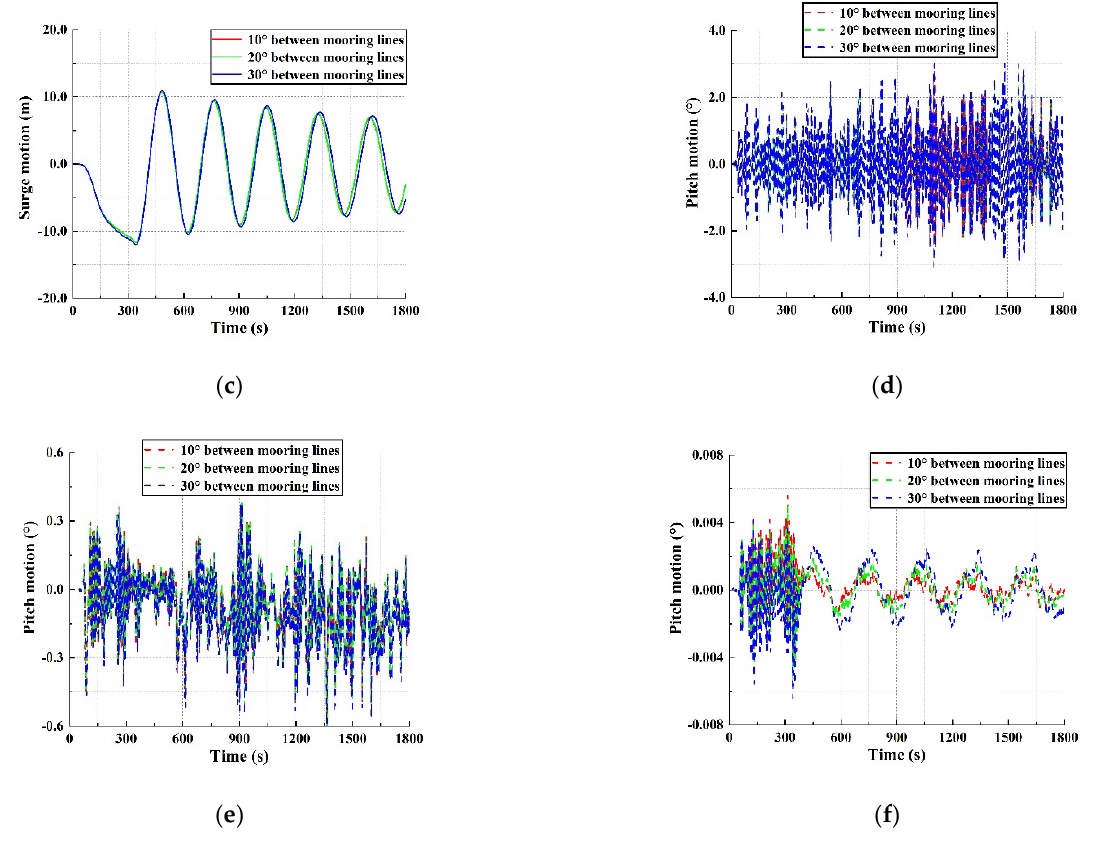
Figure 23. Influence of the angle between mooring lines on Kulluk platform motion. ( a ) Surge motion under wave loads; ( b ) surge motion under level ice loads; ( c ) surge motion under broken ice floes loads; ( d ) pitch motion under wave loads; ( e ) pitch motion under level ice loads; ( f ) pitch motion under broken ice floes loads.